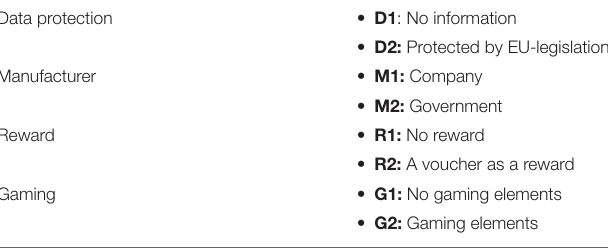
TABLE 3 | Descriptive information about the participant per